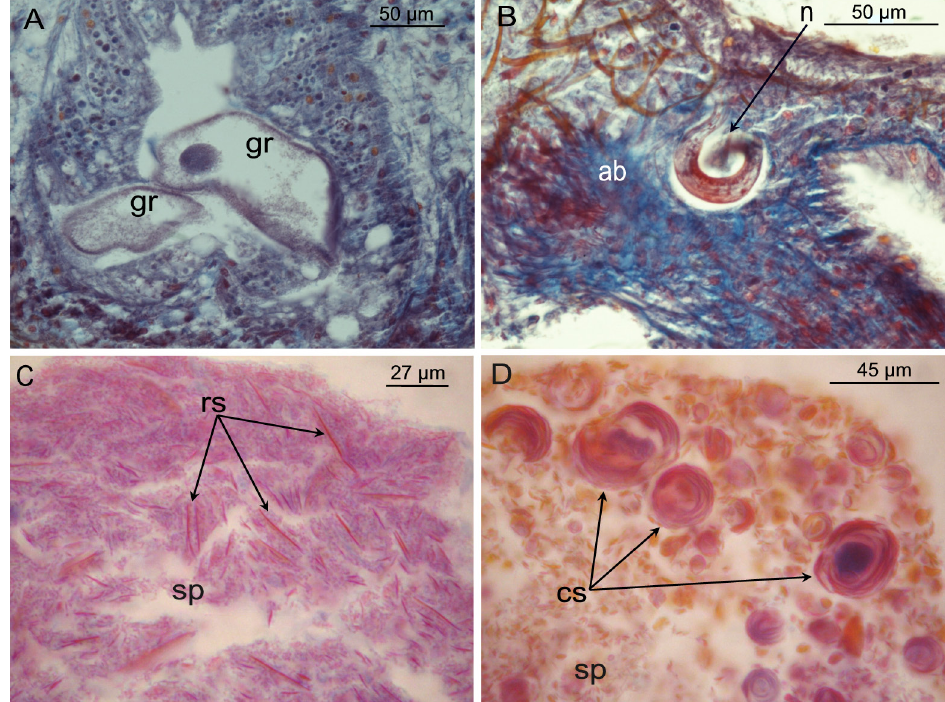
Fig. 5. Dendrocoelum obstinatum Stocchino & Sluys, sp. nov. A . Holotype (ZMA V.Pl. 7264.1), microphotograph of gregarine protozoans in a gut diverticulum. B . Specimen from the Movile Cave, microphotograph of a nematode infecting the bulb of the adenodactyl (ZMA V.Pl. 7265.2). C . Holotype, microphotograph of the mass of sperm inside the copulatory bursa with the rod-like structures. D . Specimen from the Limanu well, microphotograph of the mass of sperm inside the copulatory bursa, with a multilayered concentric organization of the circular structures (ZMA V.Pl.